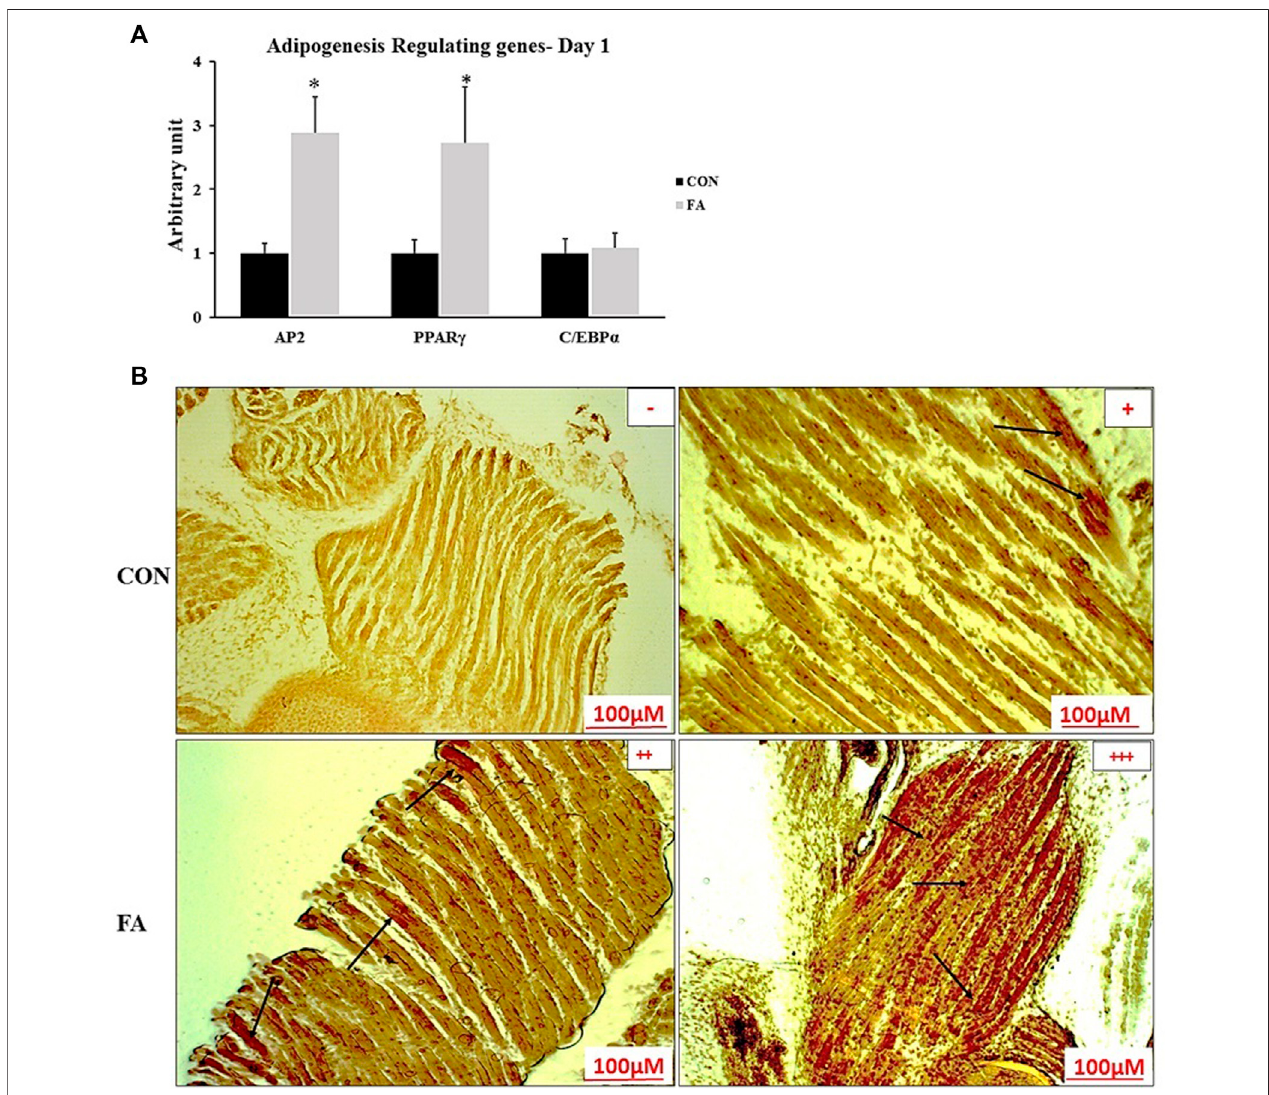
FIGURE 5 | Effect of maternal intake of EPA/DHA on ectopic lipid accumulation in muscles of day 1 neonates. The mothers were fed either control diet (CON) or EPA/DHA enriched diet (FA) during the entire period of pregnancy and lactation. (A) The relative expression of adipogenesis regulating genes in neonatal muscles. The raw Ct was normalized to the value of 18 s. All data represent as mean ± SEM. p < 0.05 by Student ’ s t-test ( n = 8). (B) A representative microscopic image of muscle samples stained with Oil red O in day 1 offspring fed control diet or EPA/DHA rich diet. The magni fi cation is ×10 and scale bar is 100 μ m. Black arrows refer to accumulatedfat.( − )indicatesabsencetheaccumulationoffatneitherinthesarcoplasmofthe fi bersnorinendomysium(between fi bers).(+)representsmildfatin fi ltration (++) indicates a moderate load. (+++) indicates an overload of